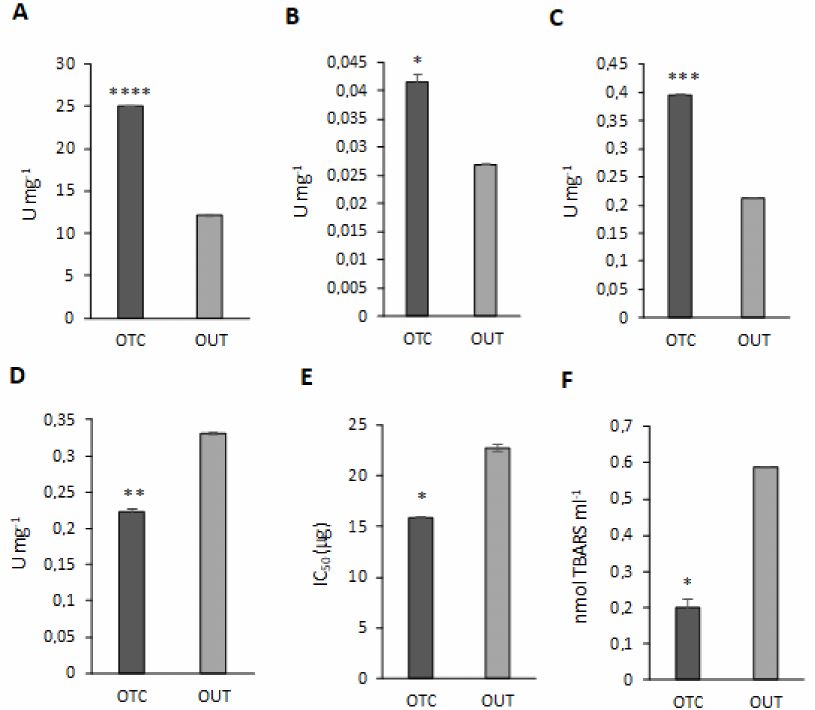
Figure 6. Antioxidant enzyme activities and TBARS content in C. quitensis leaves. ( A ) Catalase (CAT); ( B ) glutathione S-transferase (GST); ( C ) guaiacol peroxidase (POD); ( D ) ascorbate peroxidase (APX); ( E ) superoxide dismutase (SOD); ( F ) TBARS content. Data represent the mean ± SD from three biological and three technical replicates. Asterisks indicate significant differences (Student t -test: * p < 0.05; ** p < 0.01; *** p < 0.001; **** p <